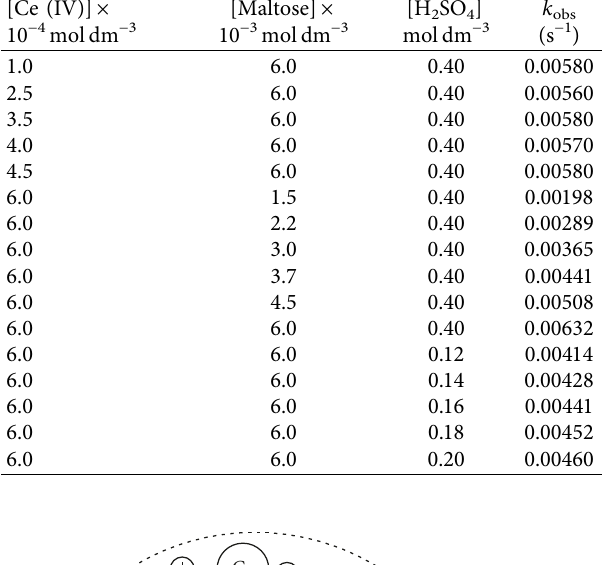
Table 1: k obs values at various concentrations of Ce (IV), maltose, and H 2 SO 4 at 298K.